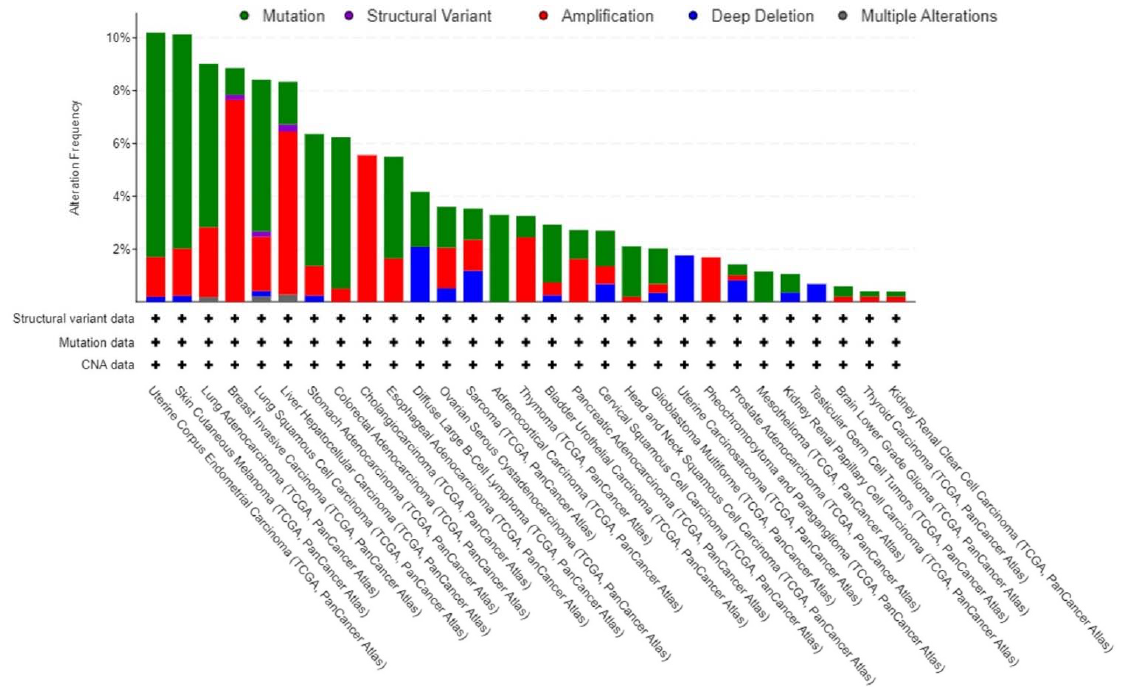
Figure 2. Genetic alteration profile of KCNH1 gene using cBioPortal. Summary of genomic alteration frequency of KCNH1 gene in different types of cancer (TCGA, PanCancer Atlas Studies). Copy- number alterations